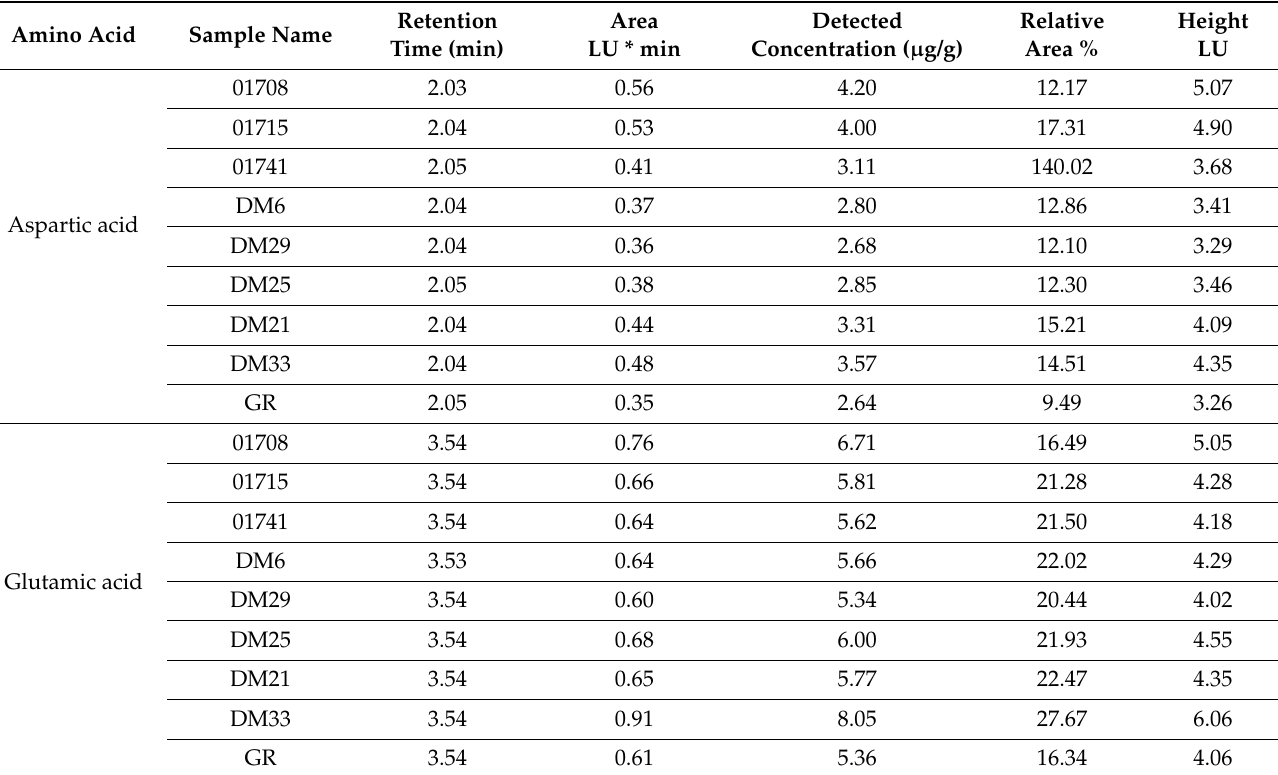
Table 1. Amino acids detected in the free fractions of nine rice varieties (01708, 01715, 01741,